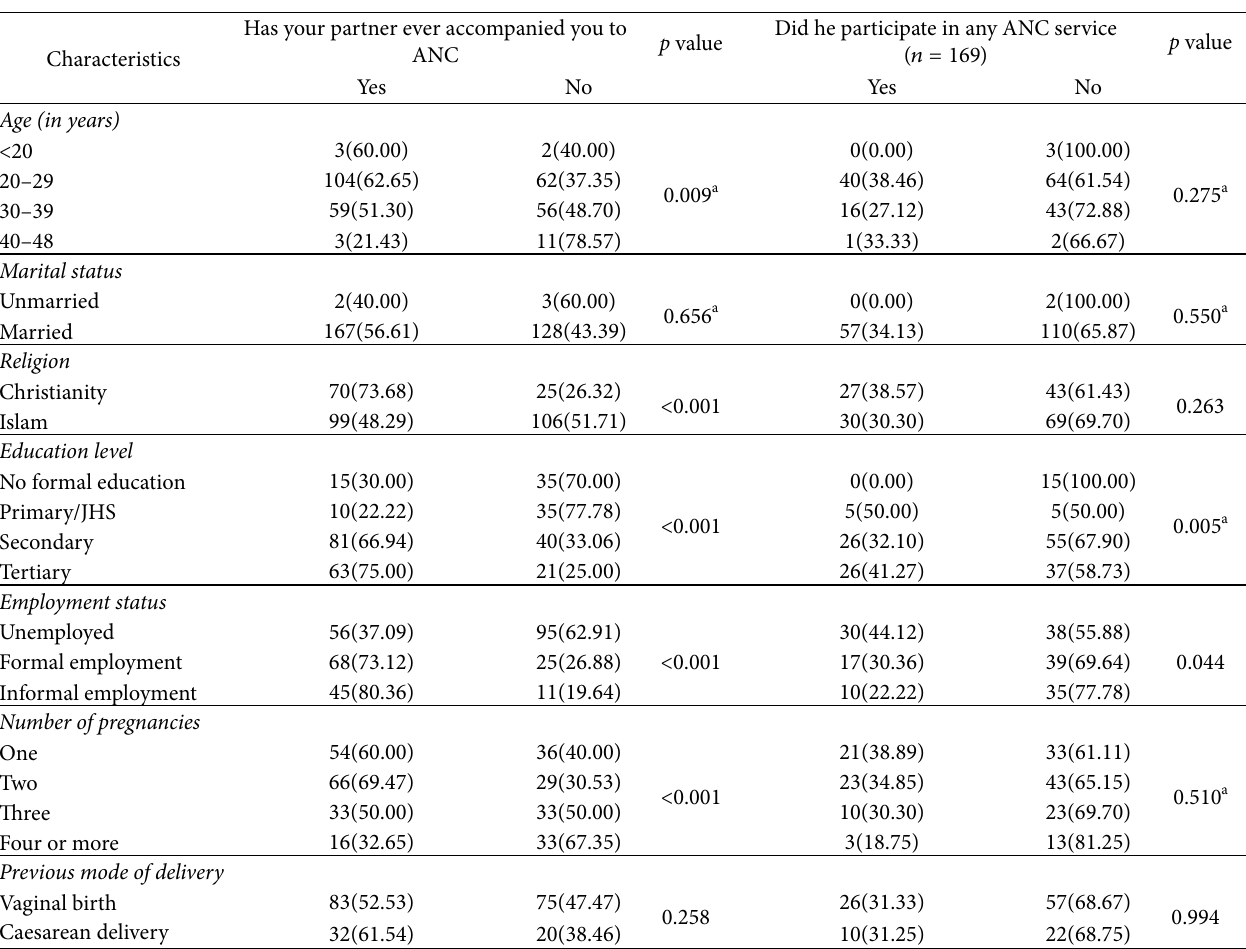
a Fisher’s exact test.